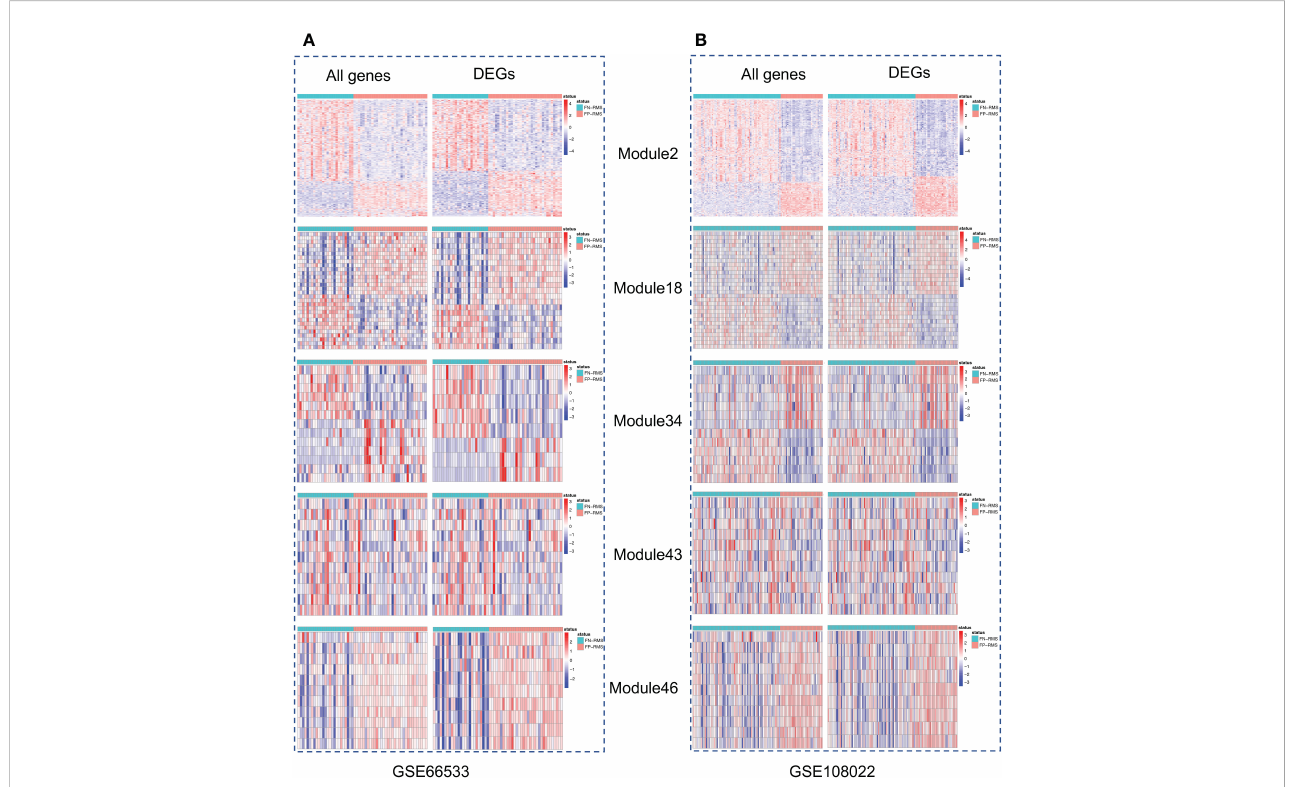
both GSE66533 dataset and GSE108022 dataset. 58.53% (295/504) genes in Module 2, 70% (21/30) genes in Module 18, 61.54% (8/13) genes in Module 34, 66.67% (8/12) genes in Module 41, and 81.82% (9/11) genes in Module 46 showed signi fi cant differential expressions between FN and FP samples in both GSE66533 and GSE108022